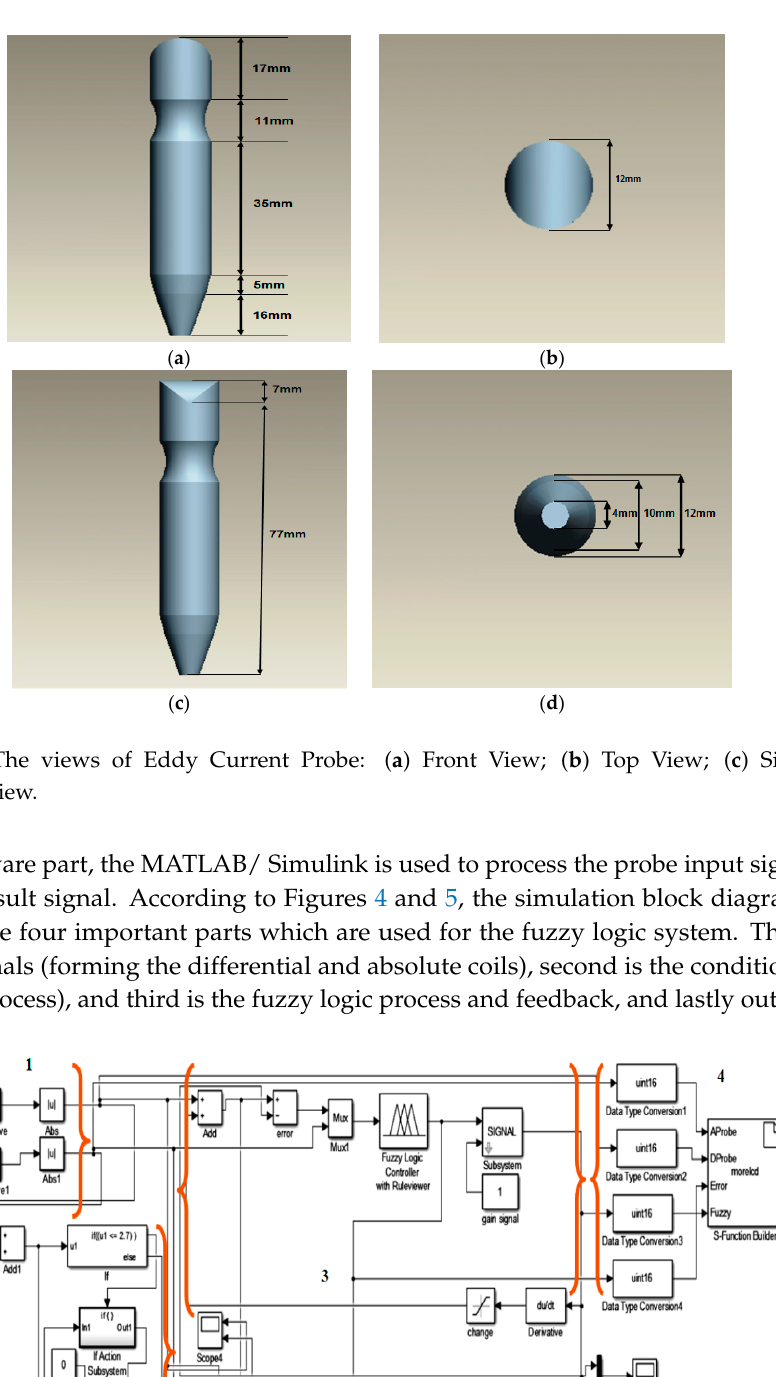
Figure 5. Basic block internal function in Fuzzy Logic. 3.3.1. Rules of Fuzzy Logic To complete the fuzzy logic block setting, the rule of the fuzzy block is set according to the rule editor for lift-off and depth measuring blocks. Table 2 shows the nine rules which have been set based on the Mamdani-type fuzzy rule algorithm.